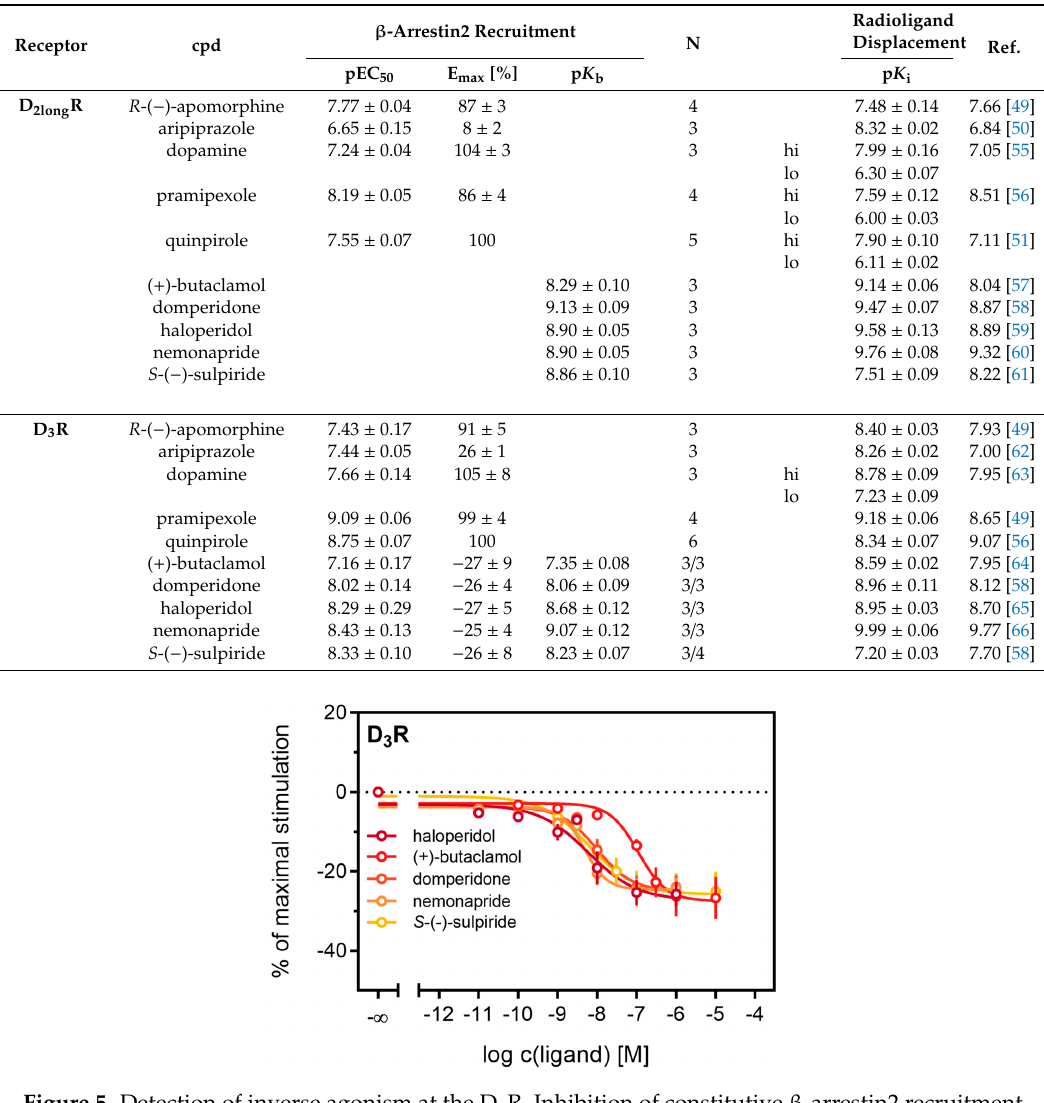
Figure 5. Detection of inverse agonism at the D 3 R. Inhibition of constitutive β -arrestin2 recruitment to the D 3 R by shown D 3 R ligands. Results are presented as percent maximal stimulation as that observed with quinpirole [1 µM]. Data represent means ± SEM from three independent experiments, each performed in triplicate.